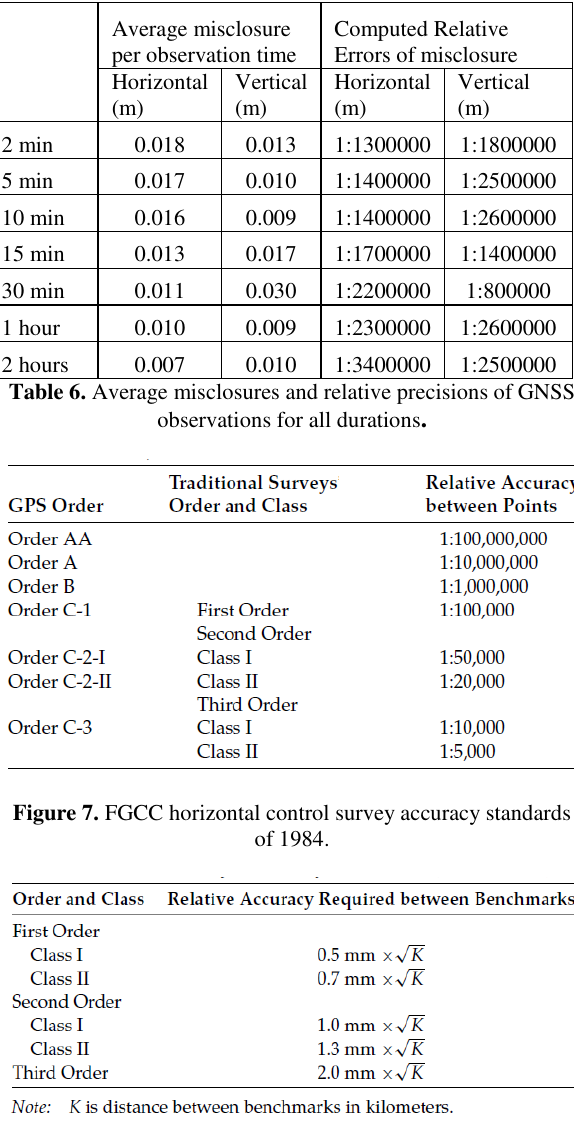
Figure 8. FGCC vertical control survey accuracy standards of Figure 9. RMSE of horizontal and vertical observations using 1984. all GNSS signals with the biases in horizontal and vertical observations in MMA3289 still retained. Y-axis in